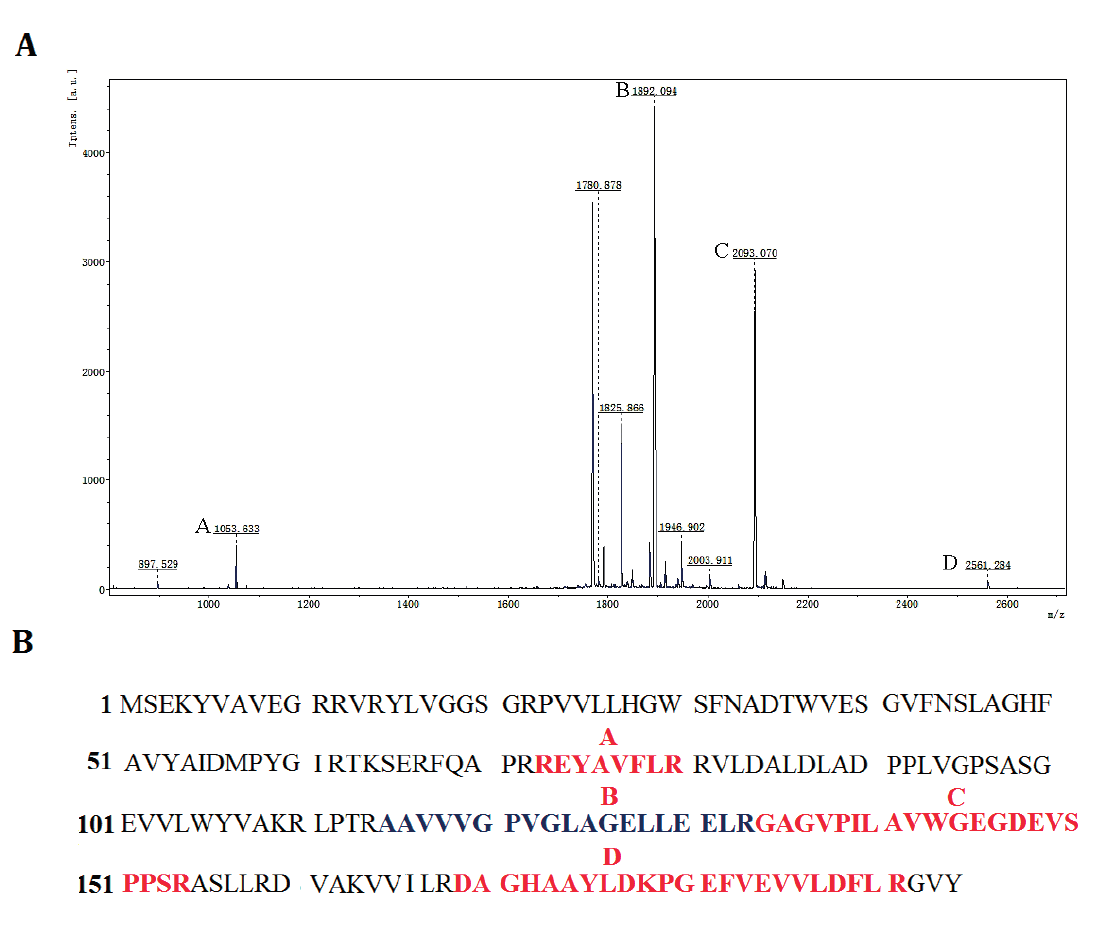
Figure 5. Identification of rP186_1588 by peptide mass fingerprinting analysis. ( A ) MALDI-TOF spectra of rP186_1588, x -axis: m / z ratio; y -axis: species abundance in terms of percent signal intensity. Major peaks corresponding to the predicted peptides are marked as A, B, C, and D; ( B ) The peptide fragments of rP186_1588 whose molecular weights correspond to those of the peaks shown in the peptide mass